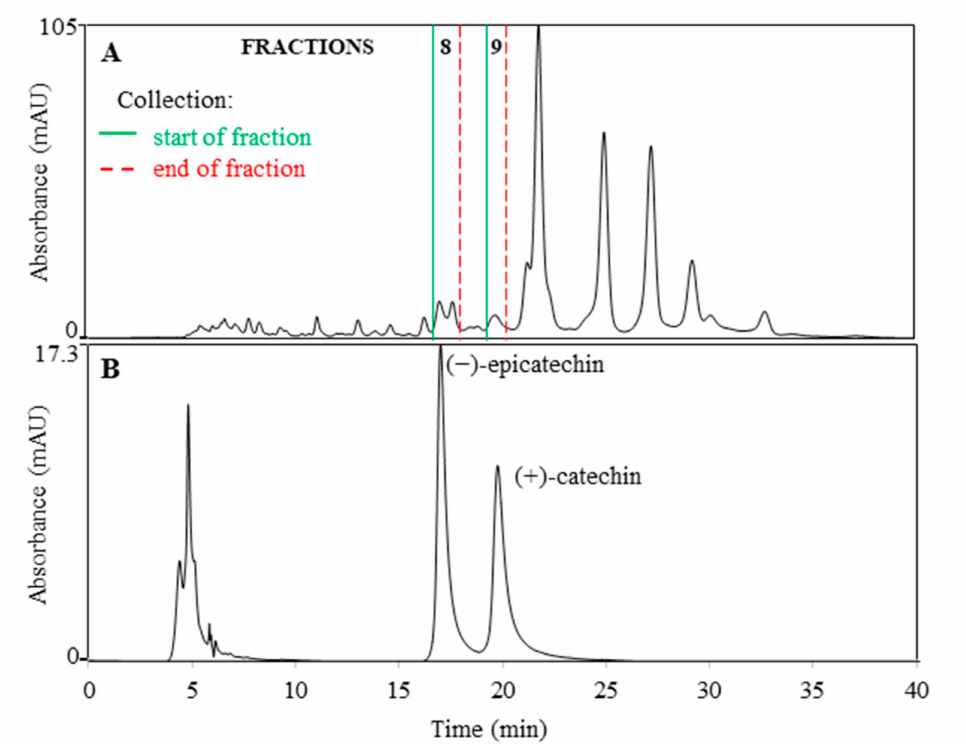
Figure 7. Matching the t R s of the antioxidant fraction FR 8 ( A ) and ( − )-epicatechin ( B ), and the t R s of FR 9 ( A ) and (+)-catechin ( B ). Chromatograms were acquired at 280 nm using the SEC-HPLC method.